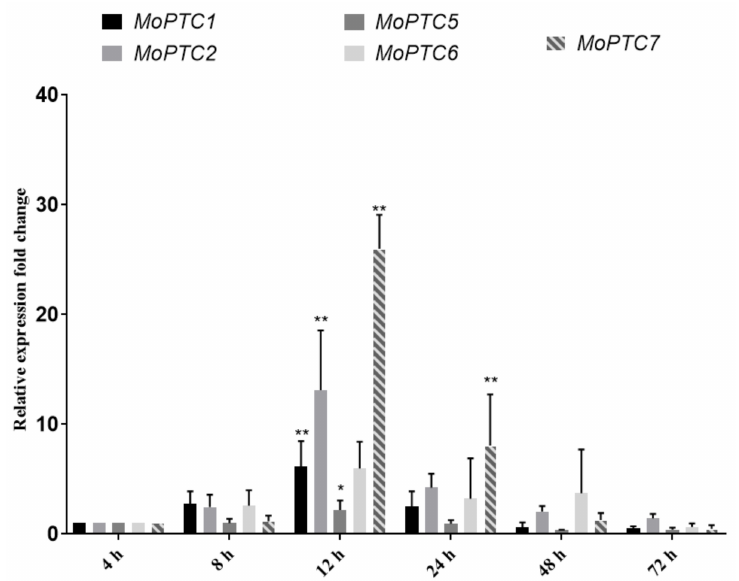
Figure 2. Transcriptional expression patterns of M. oryzae type 2C genes during interaction with host. Quantitative realtime (q-PCR) was used to check the genes expressions at the indicated time points. The 4 h time point was taken as background control with tubulin gene serving as internal control. The experiments were repeated three times with three technical replicates each. Error bars represent standard deviations while asterisks show significant differences at different p -values (* p < 0.1; ** p < 0.01). The data were analyzed by one-way ANOVA using Tukey’s multiple-comparison test.